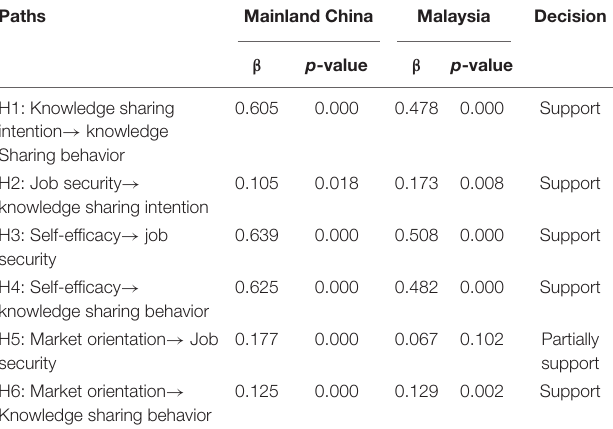
TABLE 2 | Results of the hypotheses testing.